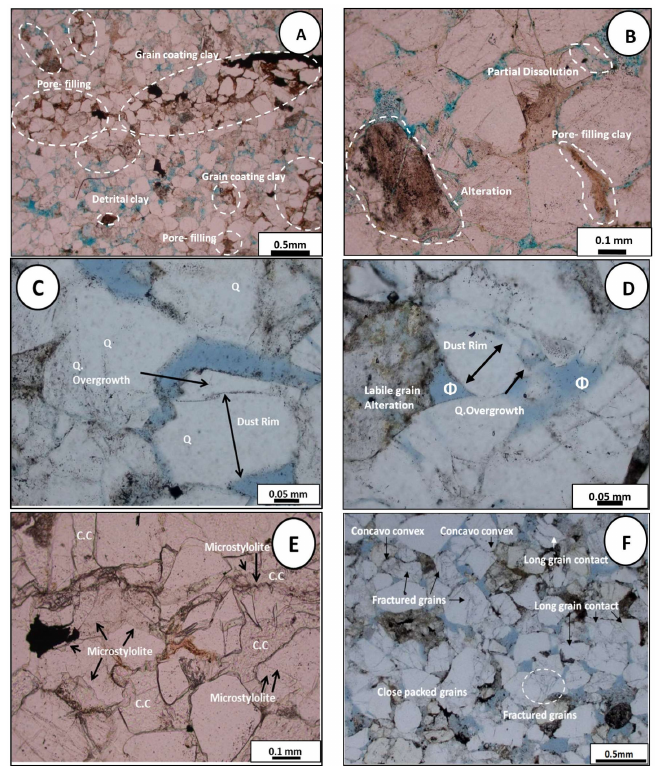
Figure 7. Thin section of medium-grained McKee sandstone with porosity-reducing features under plane-polarized light. ( A ) Well-sorted sandstone that is variably argillaceous in McKee 5A at 2328 m. ( B ) Argillaceous sandstone with small and poorly connected pores. Clay of authigenic origin can also be seen where grains are partially altered in McKee 5A at 2328 m. ( C ) Well-sorted sandstone with pores slightly affected by quartz overgrowth in McKee 6A at 2217 m. ( D ) Moderately well-sorted sandstone showed pores affected by quartz overgrowth and labile grain partially altered to clay in McKee 6A at 2240.25 m. ( E ) Heavily cemented sandstone with the presence of microstylolites in McKee 4 at 2463 m. ( F ) Moderately well-sorted sandstone with compaction effects such as concave-convex, long